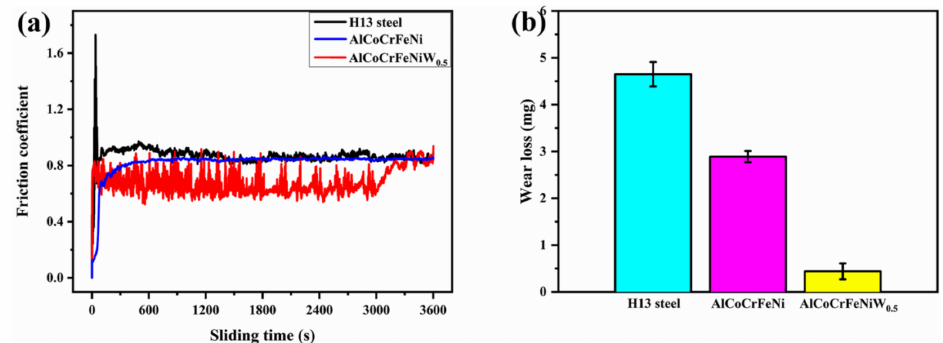
Figure 6. ( a ) The high temperature friction coefficient curves: H13 steel (black), AlCoCrFeNi (blue), AlCoCrFeNiW 0.5 (red); ( b ) High temperature wear loss: H13 steel (cyan), AlCoCrFeNi (purple), AlCoCrFeNiW 0.5